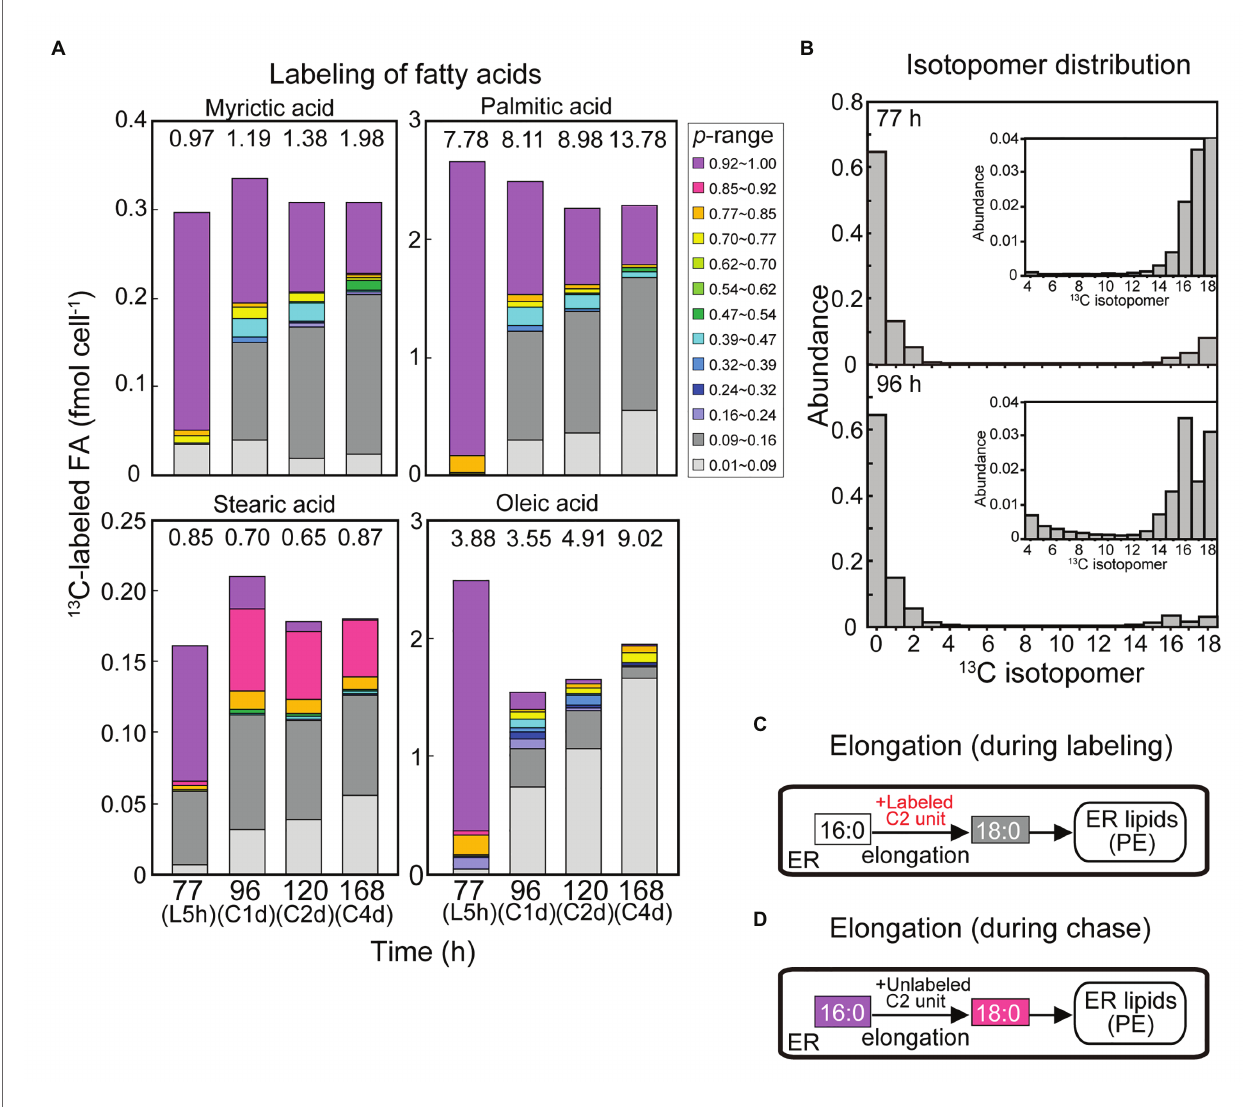
FIGURE 9 | Curious labeling pattern in stearic acid in the [ 13 C]bicarbonate labeling and chase experiments. (A) Composition of isotopic abundance populations in saturated fatty acids and oleic acid. (B) Isotopomer distribution of stearic acid after the labeling for 5 h and after the chase for 1 day. (C,D) Explanation of stearic acid labeling by elongation during the labeling (C) and the chase (D)